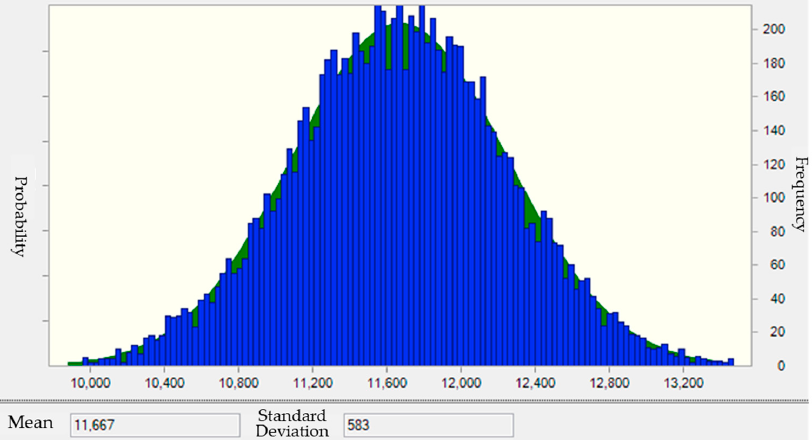
Figure 4. Probability distribution for commercial operations and maintenance (O&M) costs (normal distribution).